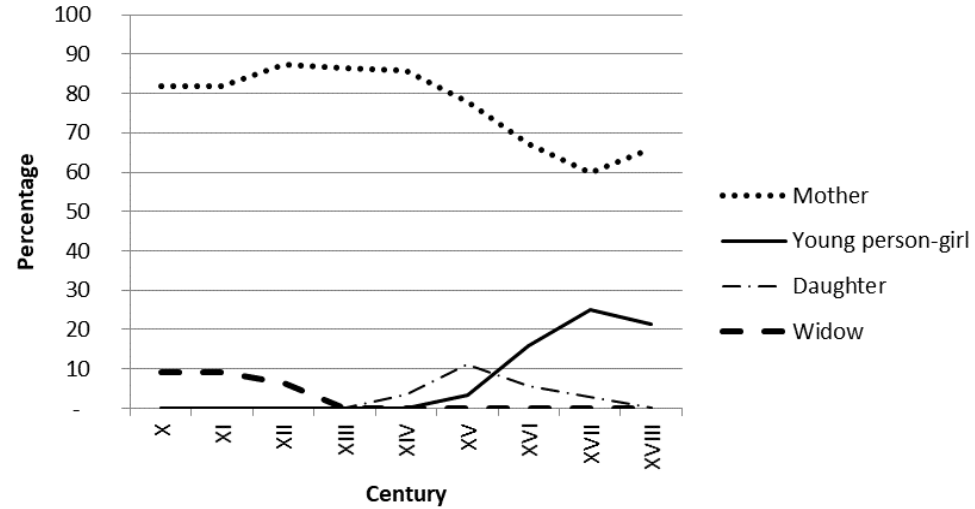
Figure 4. Representations of Mary as a young person or girl (Spain, tenth to eighteenth centuries). Source: Authors’ elaboration based on Trens (1946).